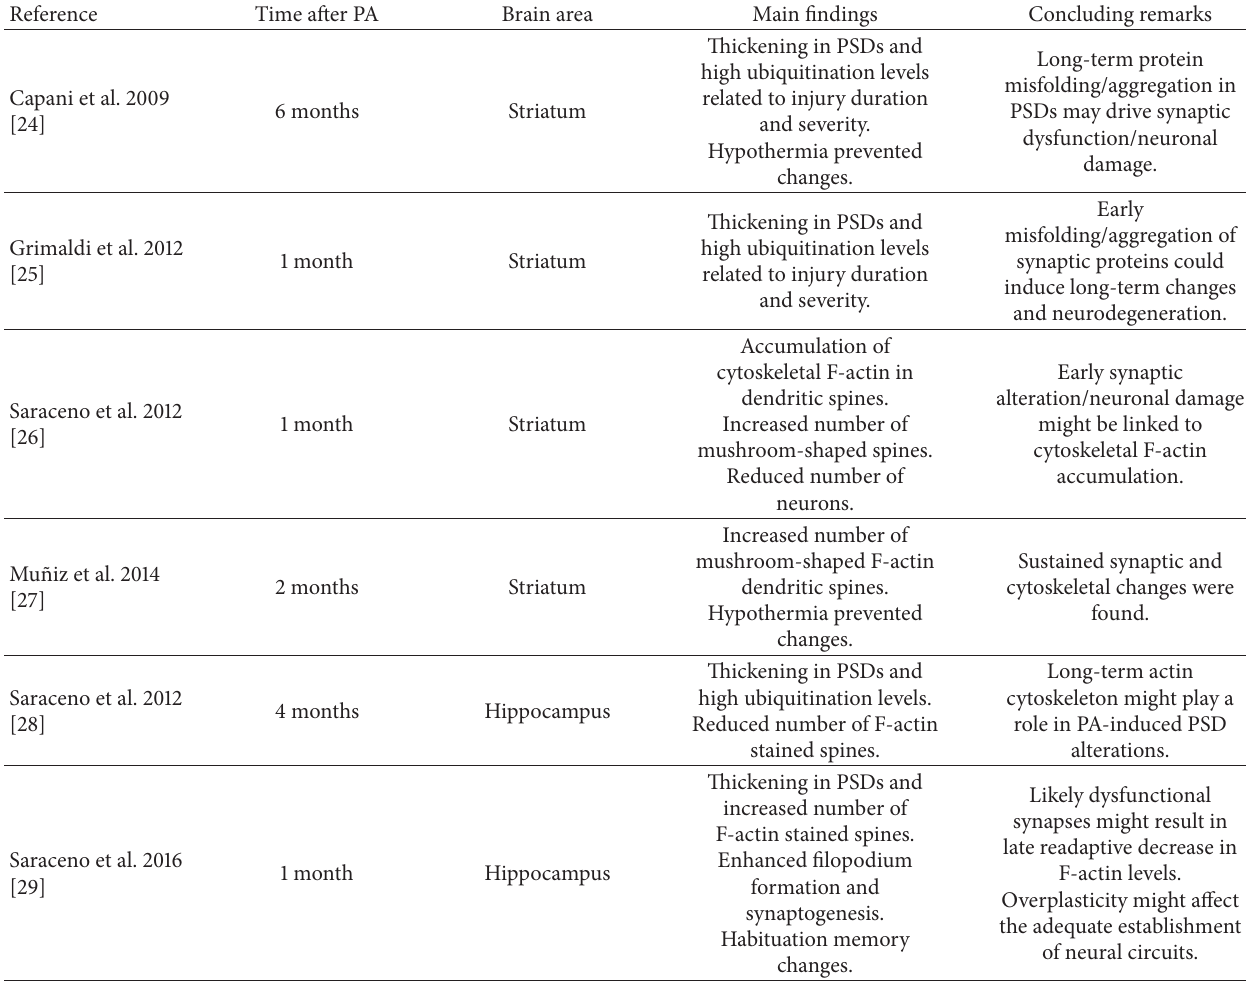
Table 1: Summary of PA-induced changes from our